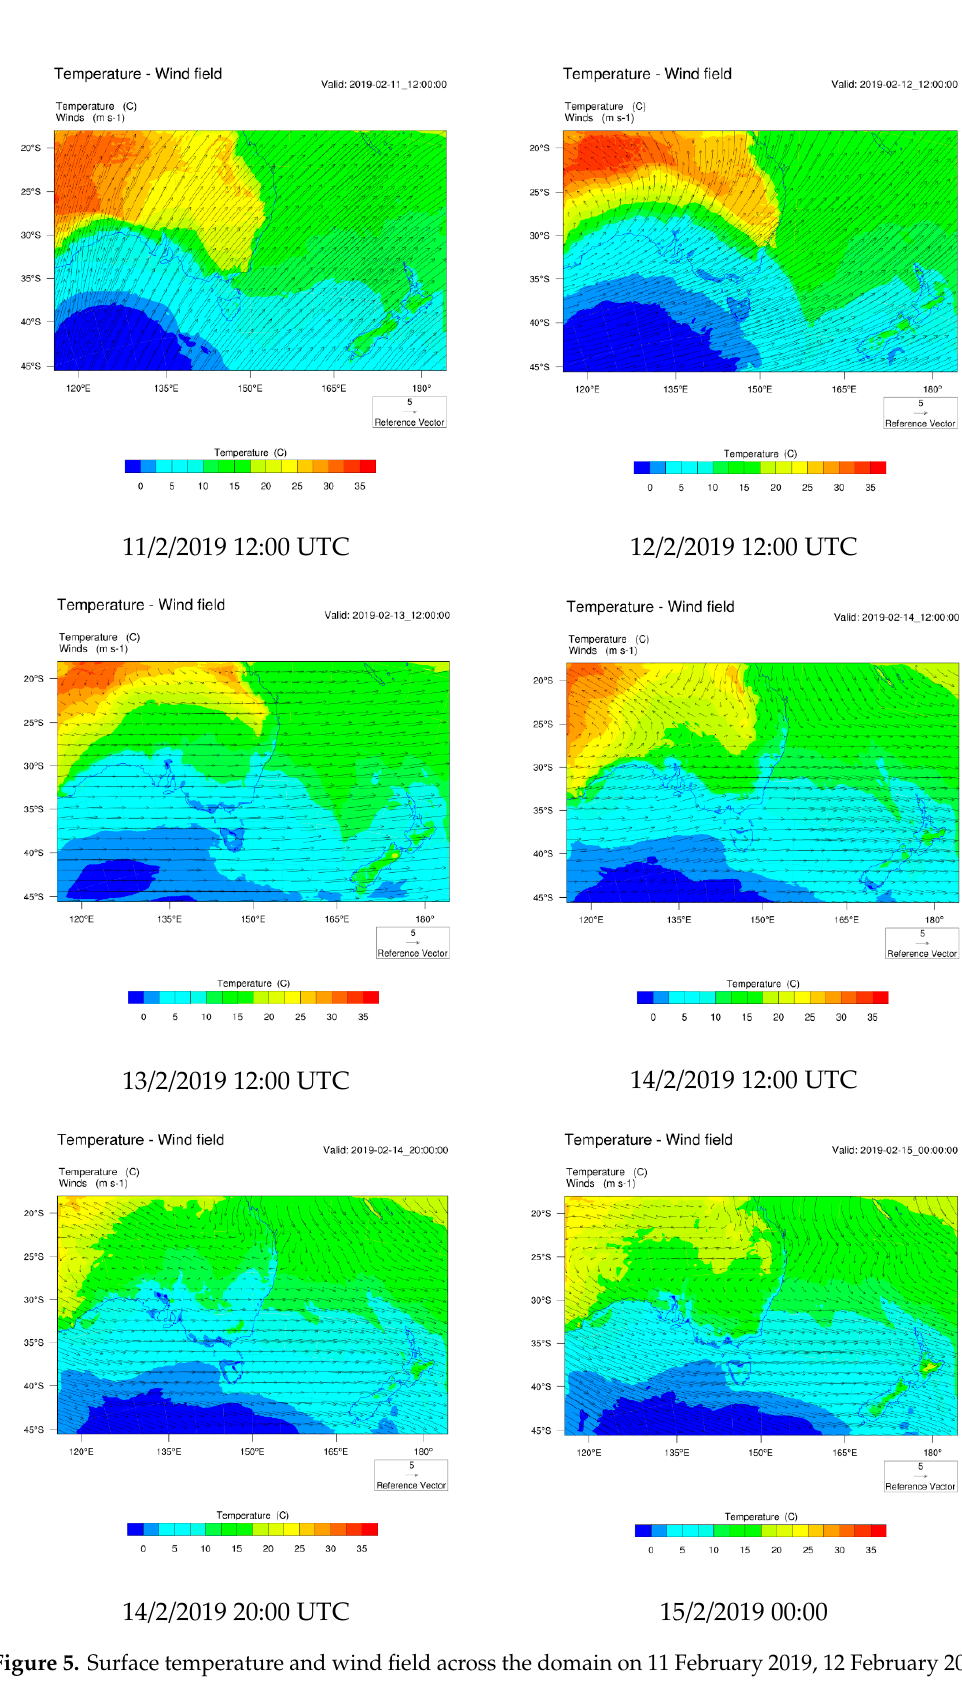
Figure 5. Surface temperature and wind field across the domain on 11 February 2019, 12 February 2019, 13 February 2019, and 14 February 2019 12:00 UTC. From 14 February 2019 12:00 UTC to 15 February 2019 00:00 UTC, the wind changed from easterly to north easterly at longitude 170 and